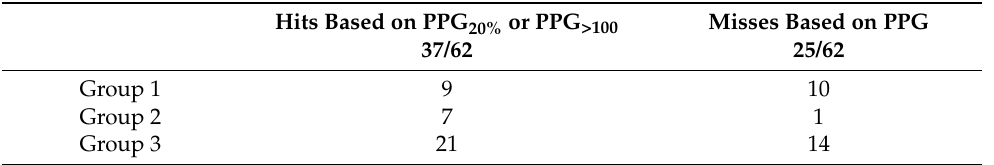
Table 2. Number of hits and misses based on at least one of the two PPG-based thresholds and divided into non-motor seizures (group 1) and seizures with non-relevant (group 2) or relevant (group 3) epileptic movements,